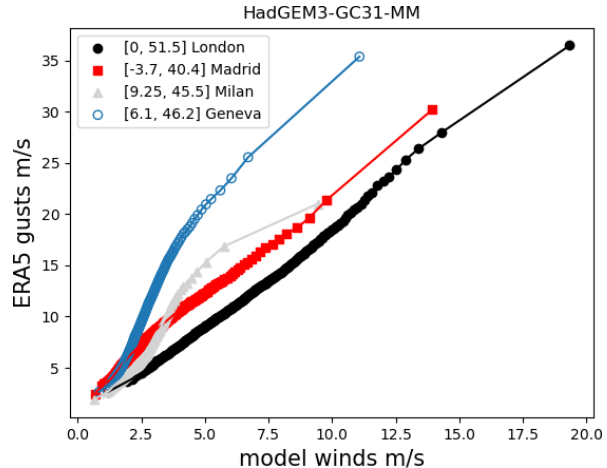
Figure 3. q - q plots at selected locations (points in increments of 0.5%) showing the relationship between ERA5 daily maximum 3s gusts and daily maximum model winds in HadGEM3-GC31- MM. The PRIMAVERA wind speeds have been linearly interpo- lated to the ERA5